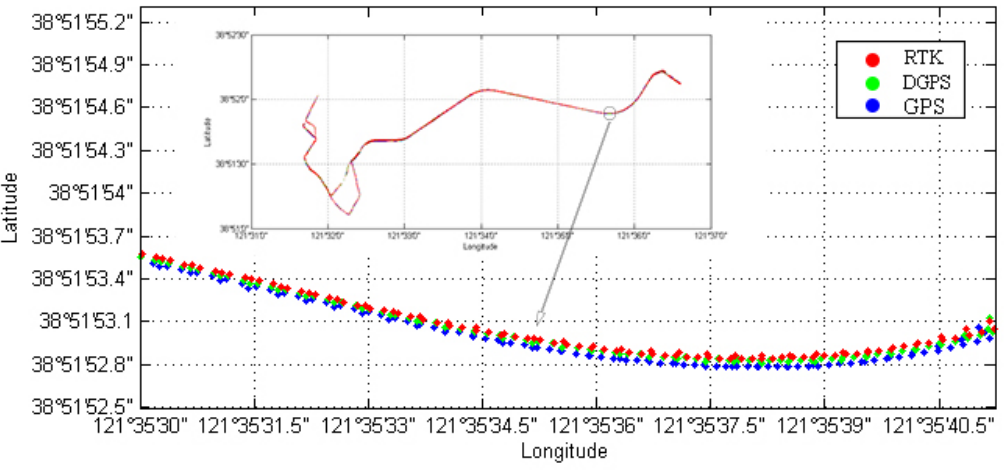
Figure 9. Vessel trajectory for the dynamic positioning